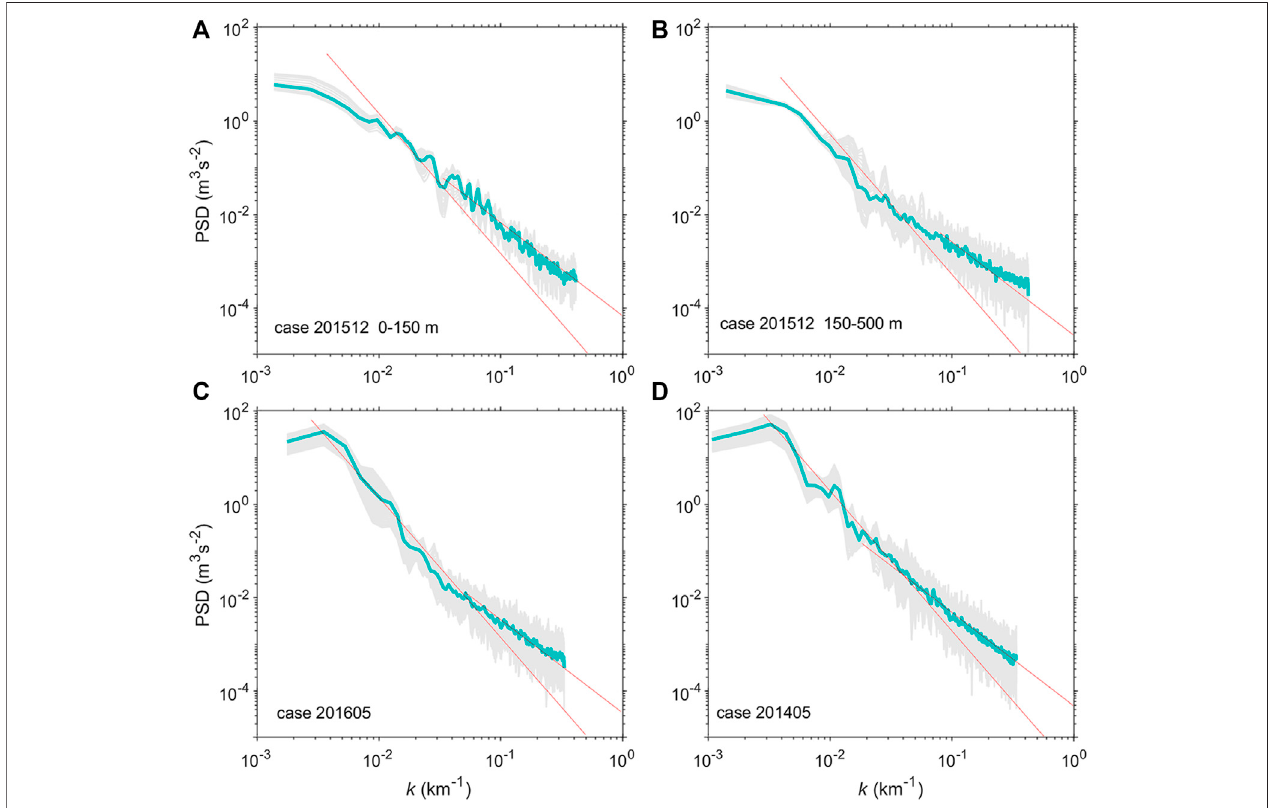
FIGURE4 | Kinetic energy spectra ofdifferent cases and differentlayers. (A) Upper 150 m of case 201512; (B) layer between150 and 500 m ofcase 201512; (C) depth average (35 – 535 m) ofcase 201605; (D) depth average (35 – 540 m) of case 201405. The velocities west of 70 ° W areused to calculate the spectra to exclude the in fl uenceoftheGulfStream.Thelightgraycurvesareoriginalspectraateverydepth,thegreencurvesdenotetheaveragedstates,andtheredlinesarereferencesof k − 3 and k − 2